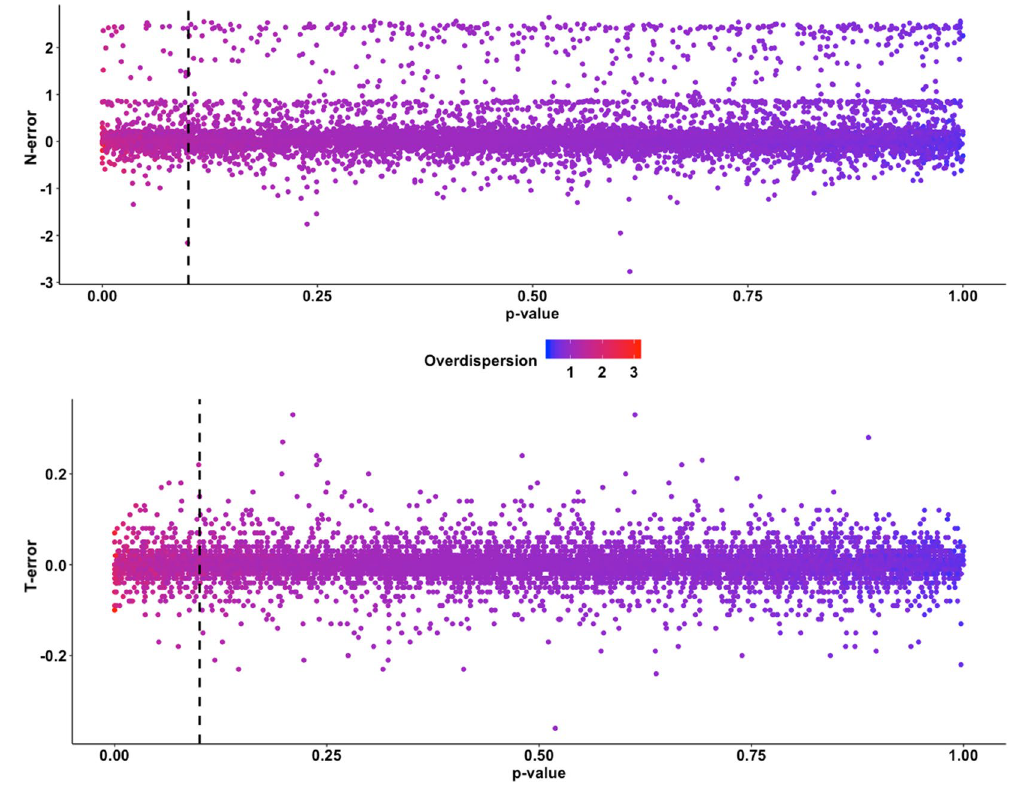
Figure 7. Scatterplots representing the relationship between the significance of the goodness of fit test and the error in abundance (top) and trend (bottom) estimation. Vertical dashed line represents the significance threshold of the